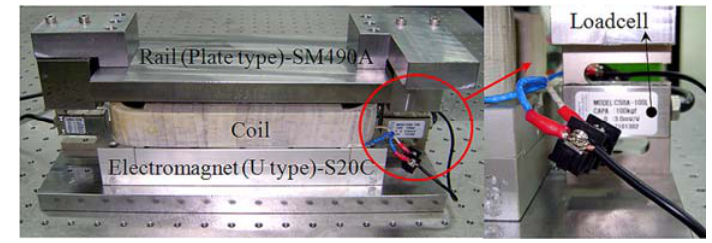
Figure 6. Prototype of the electromagnet.